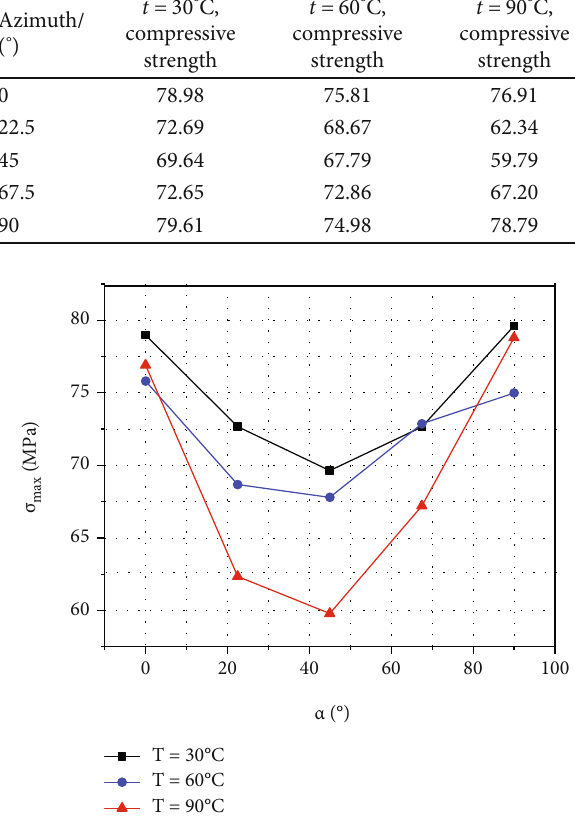
Table 3: The bedding e ff ect coe ffi cient of the compressive strength of shale.